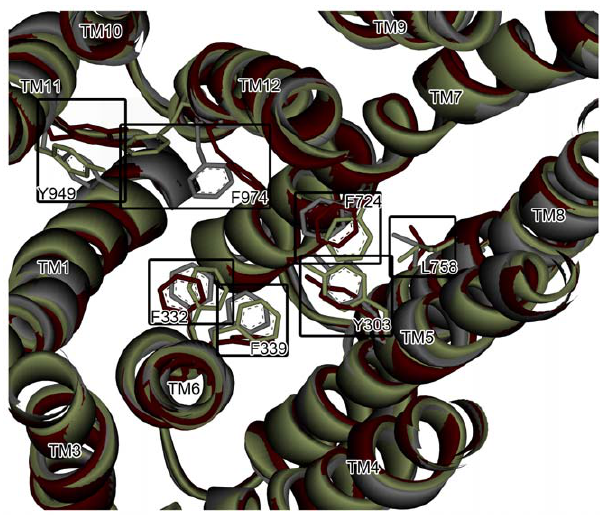
Figure 1. Superposed murine P-gp proteins. The superposition of three murine P-gp proteins, whose PDB codes are 3G5U, 3G60 and 3G61 and color-coded by gray, green and maroon, respectively.